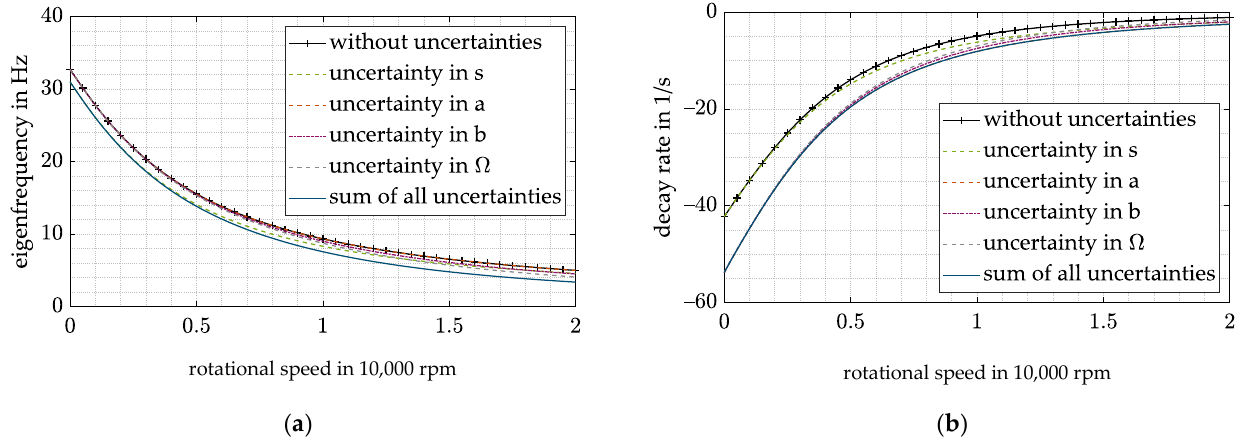
Figure 10. DVFC for the best- and worst-case combinations of all uncertainties: ( a ) Campbell diagram; ( b ) decay rate. Figure 11. Precession mode with DVFC for worst-case combination of all uncertainties: ( a ) eigenfrequency; ( b ) decay rate.